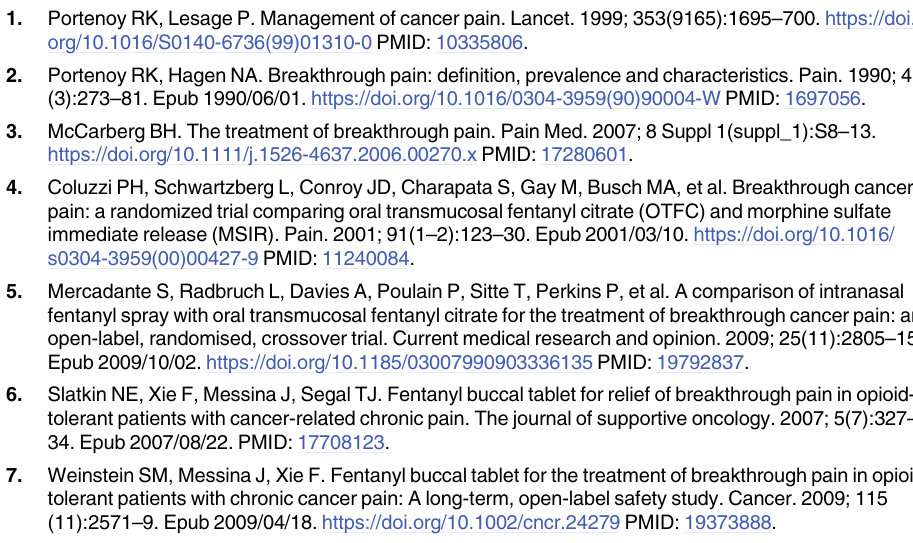
S1 Fig. Receiver operating characteristic (ROC) curves for prediction of tolerability of high-dose fentanyl buccal tablets after adjustment of age, sex, frequency of daily fentanyl buccal tablet (FBT) use, and oral morphine equivalent daily dose (MEDD). BMI, body mass index; BSA, body surface